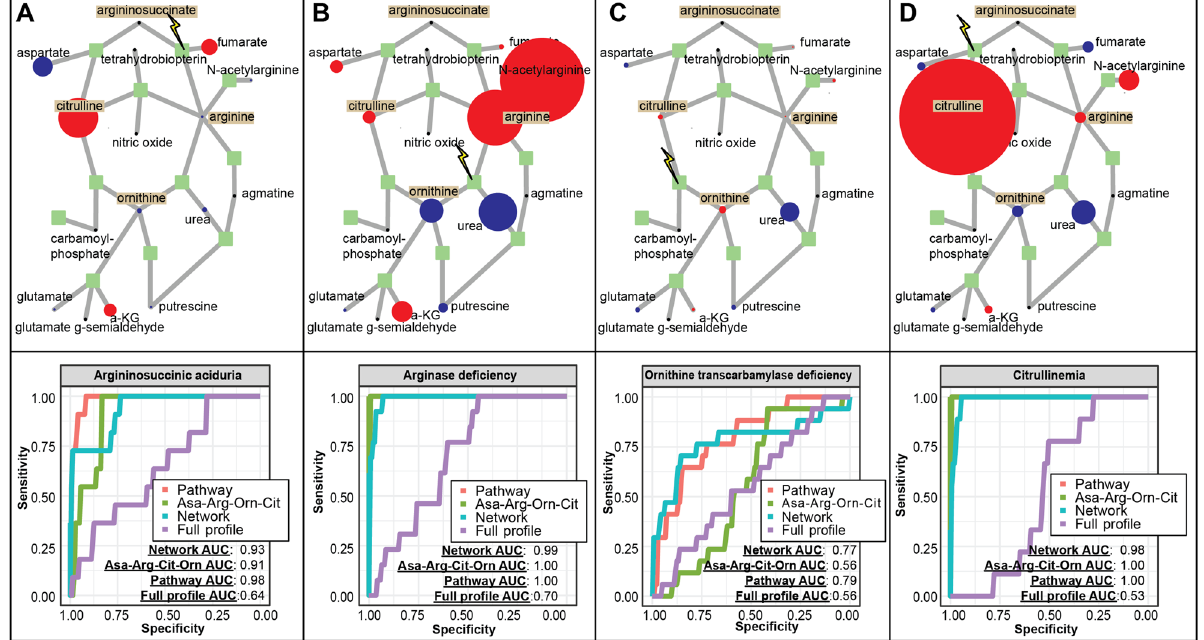
Figure 3. Data-derived networks are competitive with metabolic pathways as background knowledge network representations. For all models, ( A ) argininosuccinic aciduria, ( B ) argininemia, ( C ) ornithine transcarbamylase deficiency and ( D ) citrullinemia, the mean profile for each urea cycle disorder cohort is overlaid onto the urea cycle pathway. Red denotes a positive and blue denotes a negative perturbation, where the radius of the circle is modulated to reflect the magnitude of the perturbation. Below each urea cycle pathway, receiver-operator curves (ROC) between the two pathway-based models “ASA-Arg-Orn-Cit”, “Pathway” and the full-profile model are compared to the “Network”